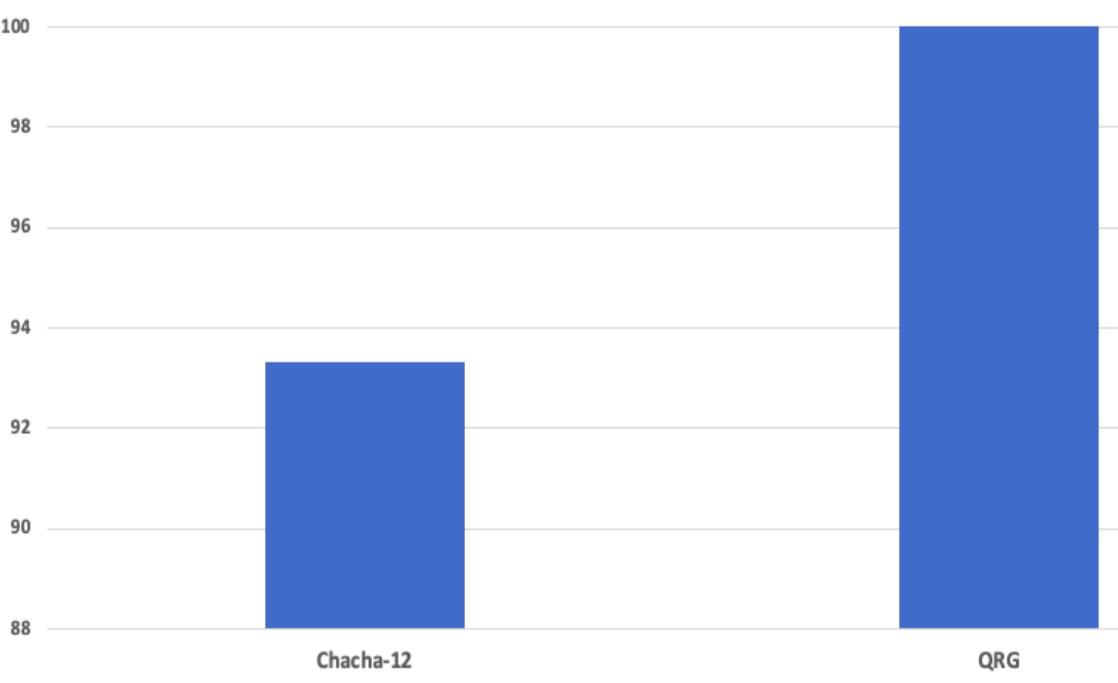
Figure 21. Percentage of passed tests for randomness scored by Chacha-12 and